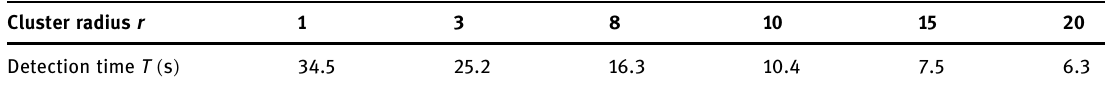
Table 8: Detection e ffi ciency of attack.log fi le Cluster radius r